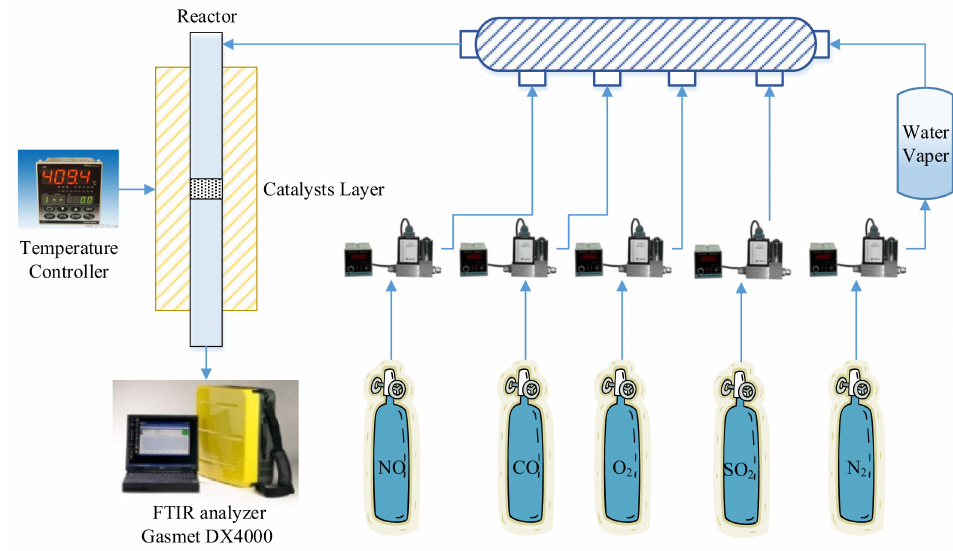
Figure 1. Catalytic activity testing system.